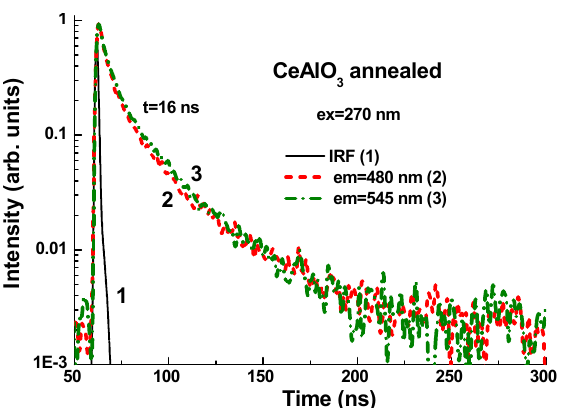
Figure 10. Normalized PL decay of annealed CeAlO 3 crystals under excitation at 270 nm and registration of emission at 480 nm ( 2 ) and 540 nm ( 3 ). ( 1 ) Instrumental response function (IRF) of laser pulse.